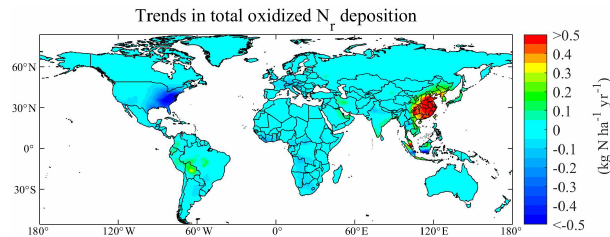
Figure 12. Gridded annual changes in total oxidized N r de- position simulated by GEOS-Chem constrained with GOME, SCIAMACHY, and GOME-2 NO 2 retrievals during 1996–2014 (Geddes and Martin, 2017). We gained the generated datasets (http://fizz.phys.dal.ca/~atmos/martin/?page_id=1520, last access: 17 July 2020) by Geddes et al. (2016) and calculated the trends using the linear